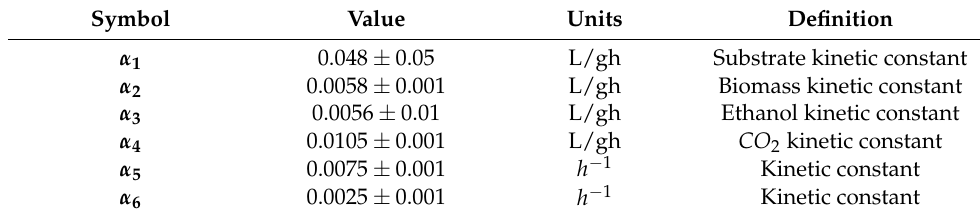
Table 2. Kinetic parameters under different operating conditions ( s 0 = 54, s 0 = 44 ).